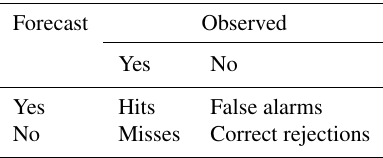
Table 2. Rain contingency table used in the verification studies. As a threshold, 6mmday − 1 is chosen to separate rain from no-rain events. Forecast